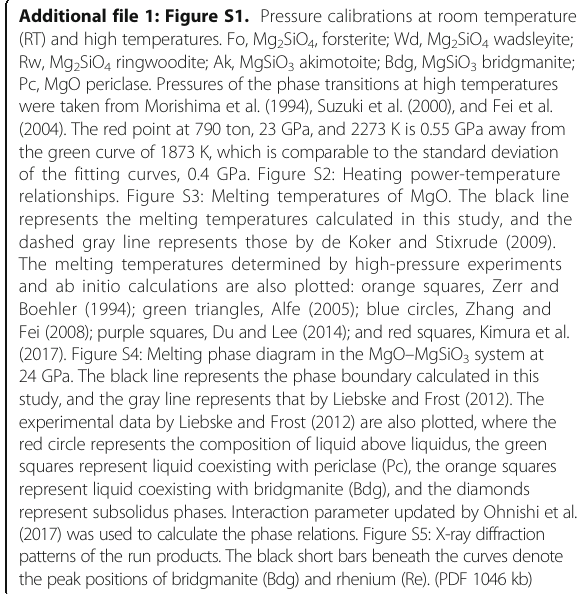
Fig. 8 Eutectic temperatures of the MgO – MgSiO 3 system calculated using interaction parameters constrained from chemical analyses of the recovered DAC samples (Ohnishi et al. 2017) and those measured directly by pyrometry in DAC experiments (Baron et al.